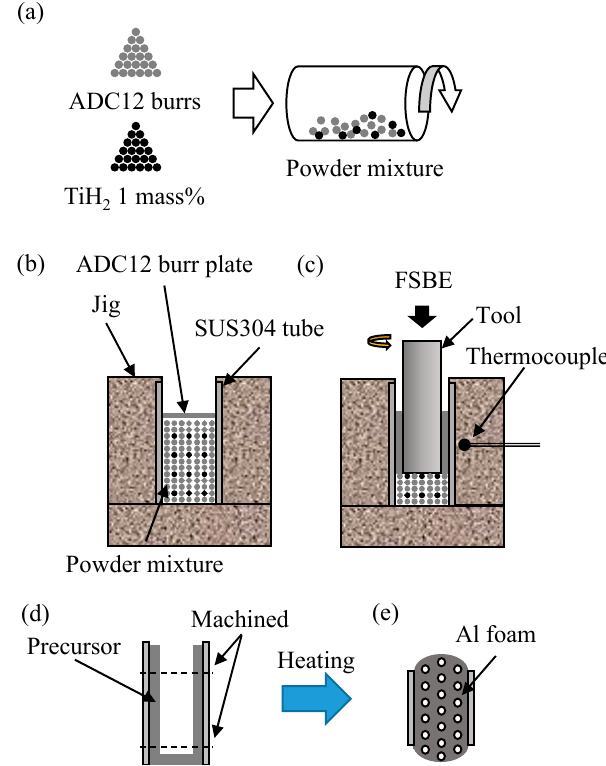
Figure 2. Schematic illustration of fabrication process of Al foam-filled steel tube by FSBE.